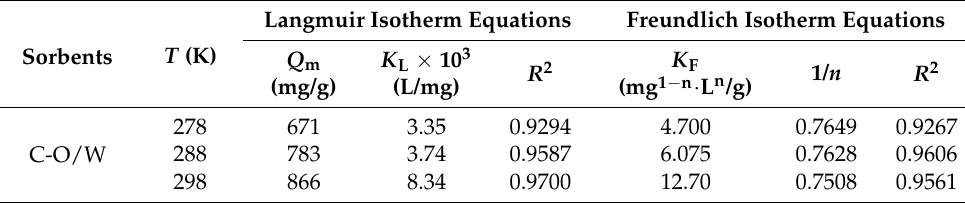
Table 2. Adsorption equilibrium constants for Langmuir and Freundlich isotherm equations.